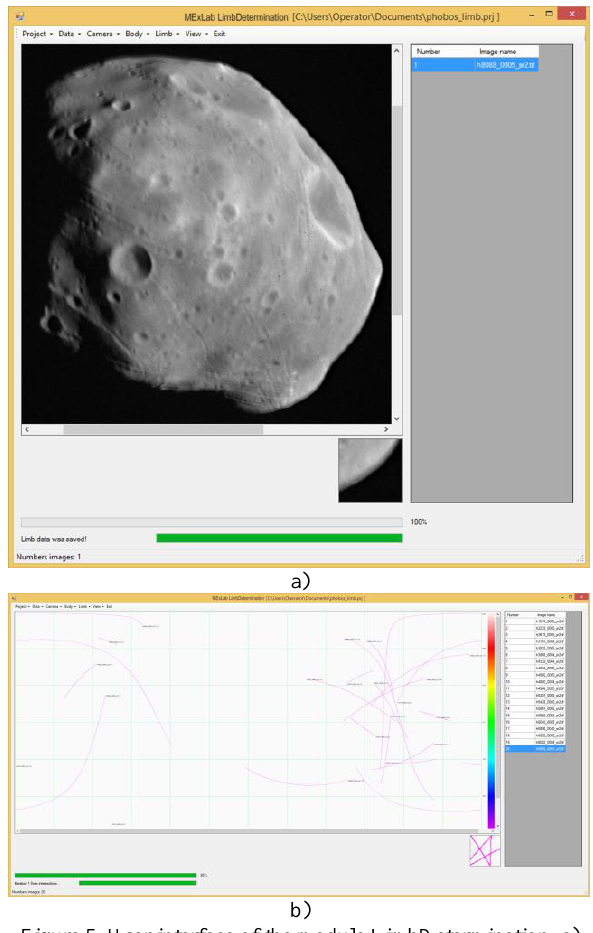
Figure 5. User interface of the module LimbDetermination: a) Mars Express-SRC image of Phobos uploaded for measurements; b) limb profiles as results of Phobos image measurements.